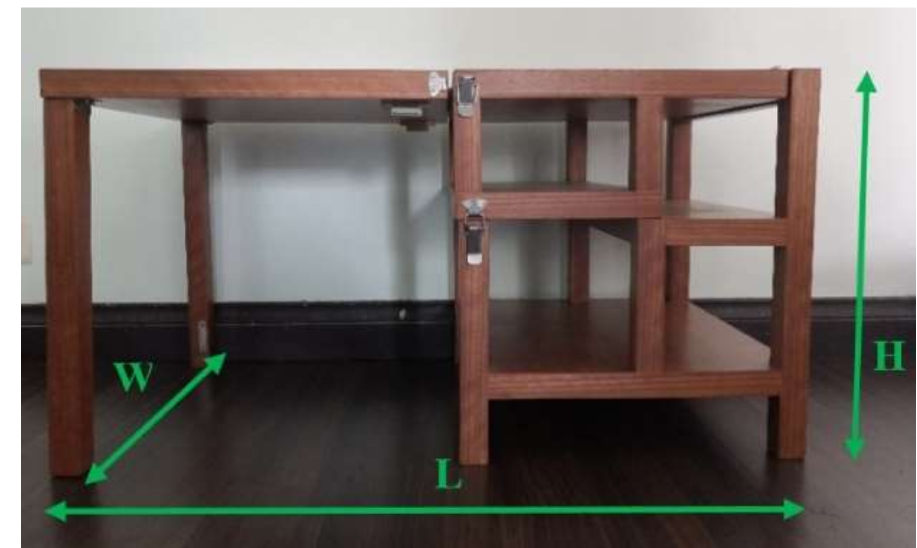
Figure 19. Dimension measurement of the space-saving multipurpose table. Notes: L—Length of table; W—Width of table; H—Height of table.